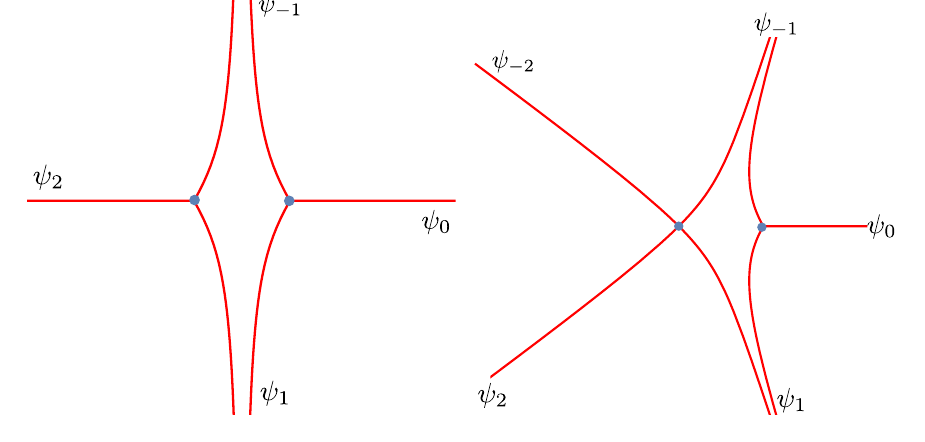
Figure 7 . Stokes diagram for (Left) P ( x ) = x 2 − 2 a , (Right) P ( x ) = x 3 − x 2